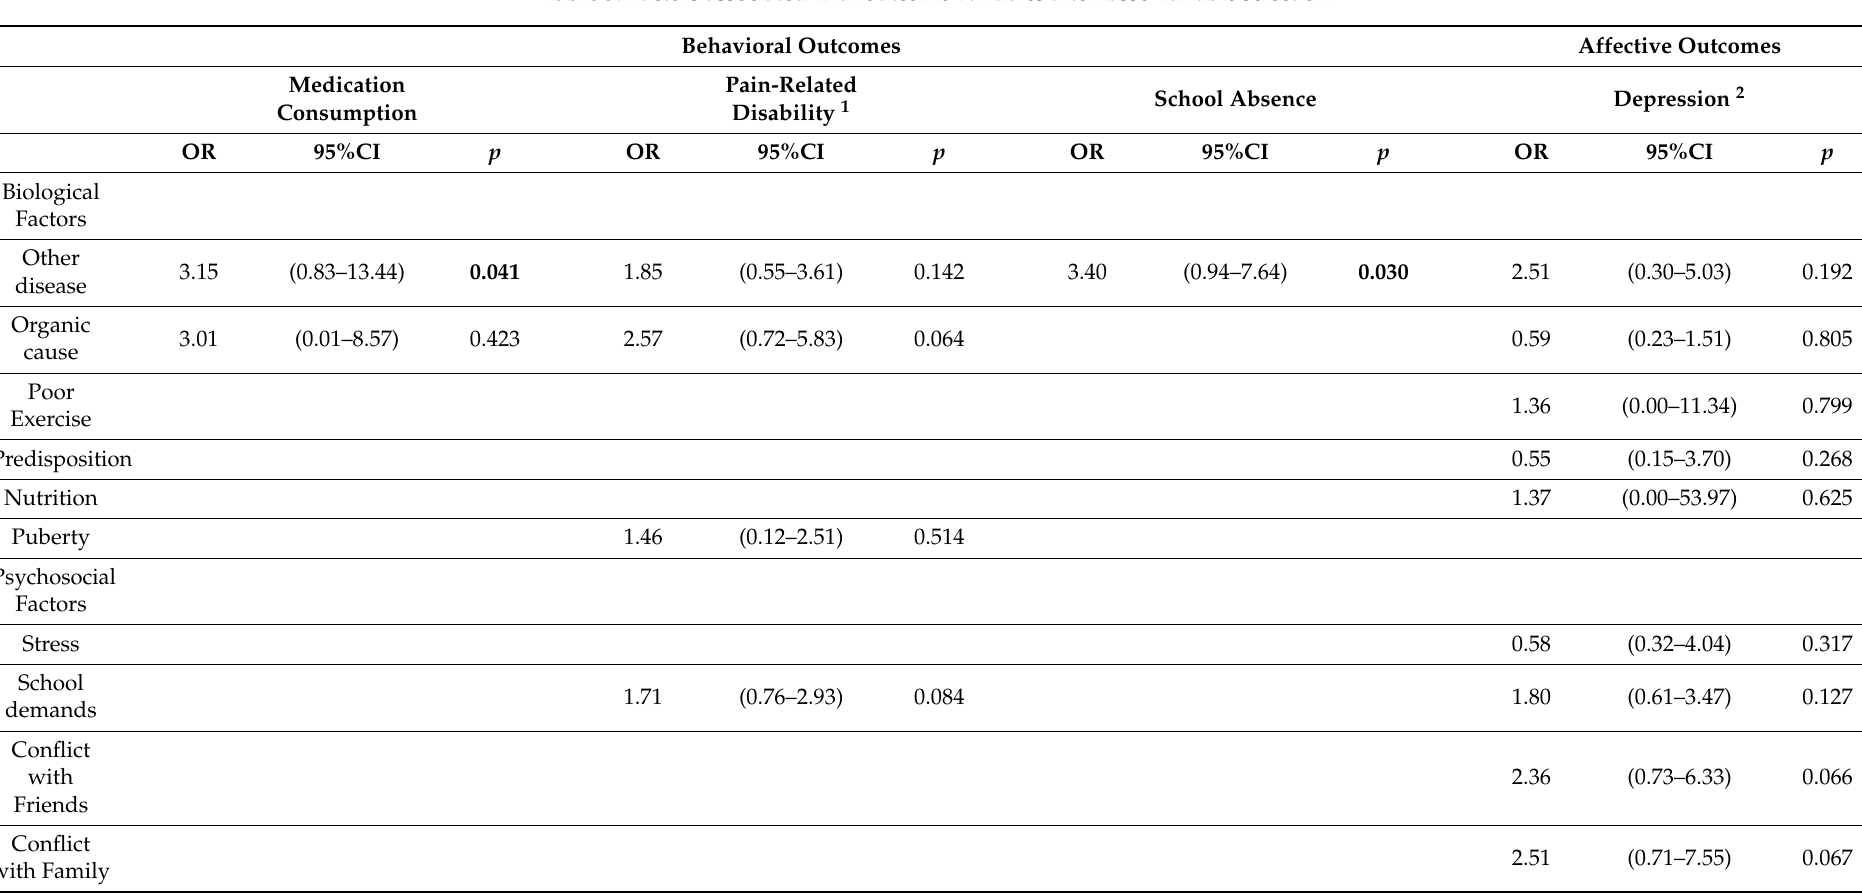
Table 3. Factors associated with outcome variables after lasso variable